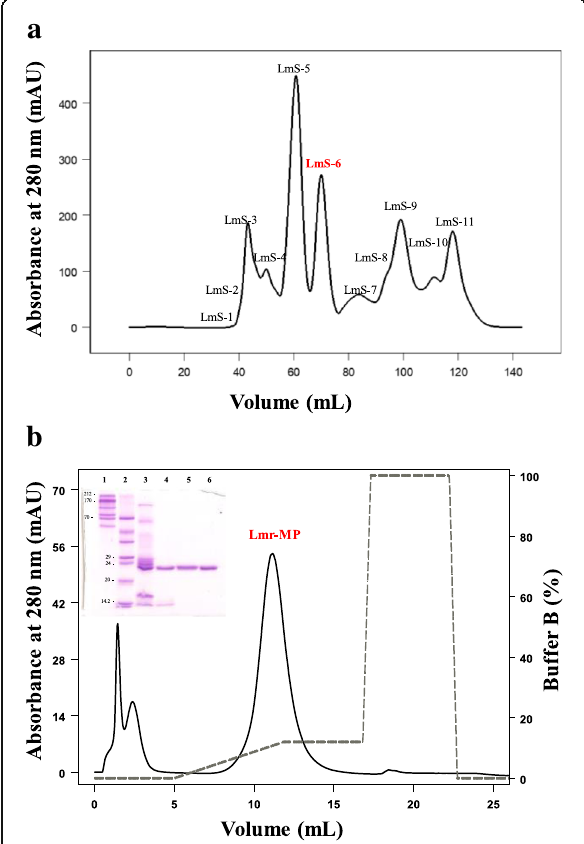
Fig. 1 Chromatographic profiles of metalloprotease from L. m. rhombeata venom. a Fractionation of Lachesis muta rhombeata venom by molecular exclusion chromatography on a HiPrep Sephacryl® S-100 HR column (1.6×60 cm) using 0.05 M sodium acetate buffer with 0.15 M NaCl, pH 6.0. L. m. rhombeata venom (23 mg) was dispersed in 500 μ L of